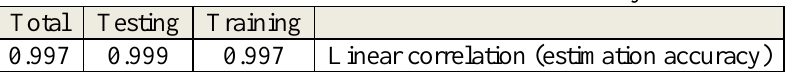
Table 8. Neural Network Estimation Accuracy.